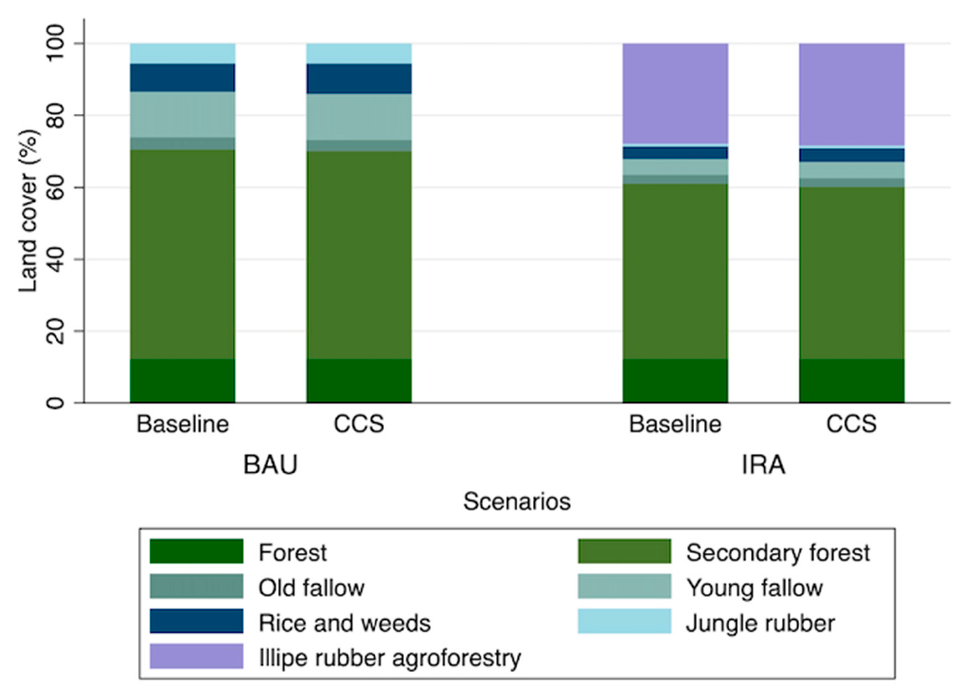
Figure A7. Simulation results: land cover in the baseline and climate change scenario.